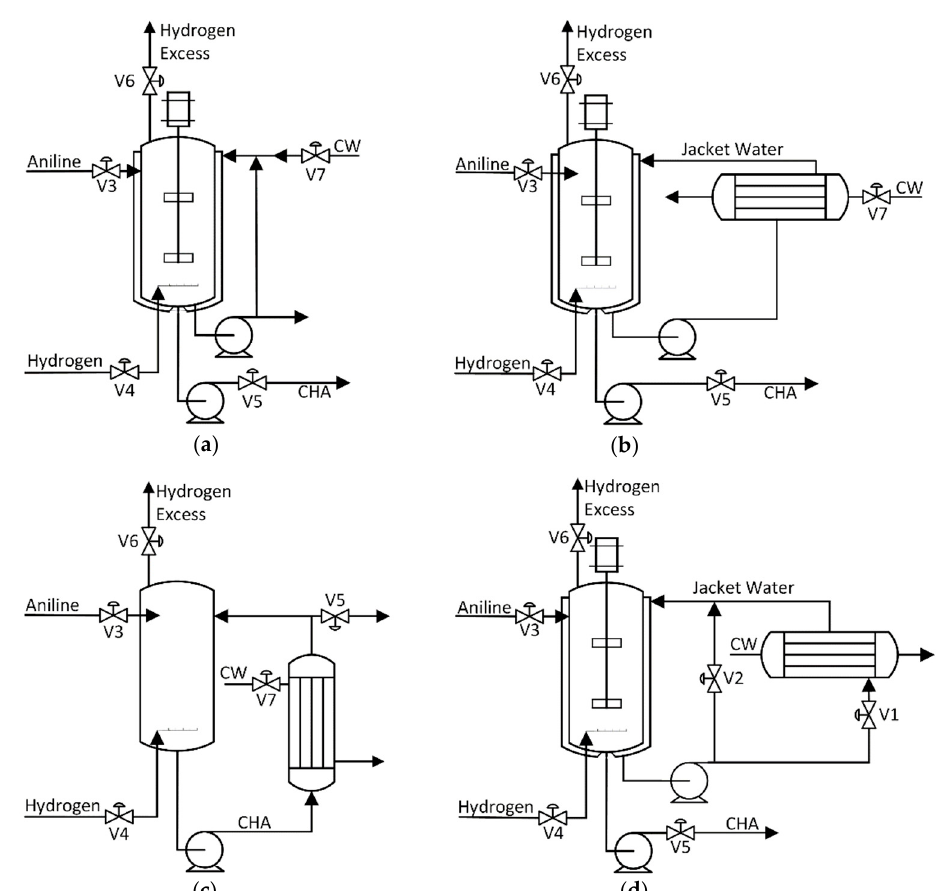
Figure 5. Schemes of the four plant designs. ( a ) Design A: jacket cooling with no heat exchanger; ( b ) design B: jacket cooling